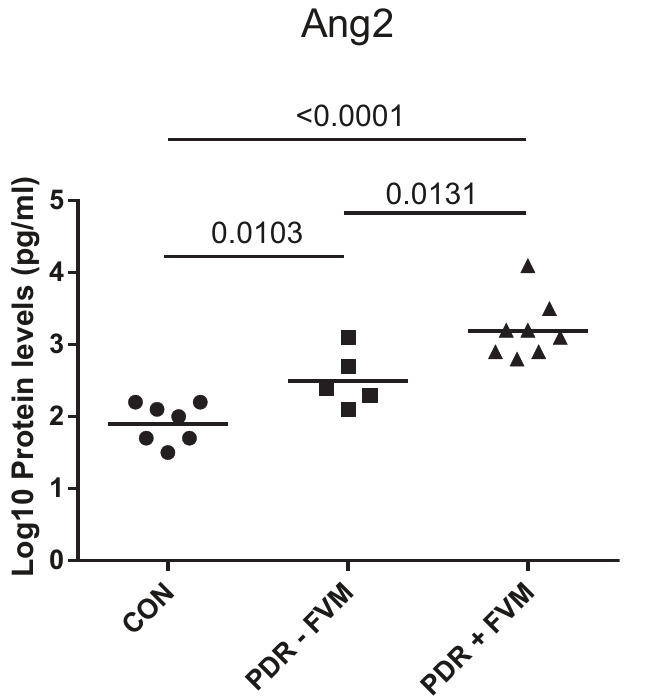
Fig 1. Ang2 protein is increased in vitreous of PDR patients with FVMs. Protein levels of Ang2, as detected by Quantibody arrays, were log10 transformed to obtain a normaldistribution.Differencesbetween groupswere analyzedby a Student’s t-test. CON, non-diabetic control patients; PDR–FVM, PDR patients without FVMs; PDR + FVM, PDR patients with FVMs. The lines represent the geometric means.